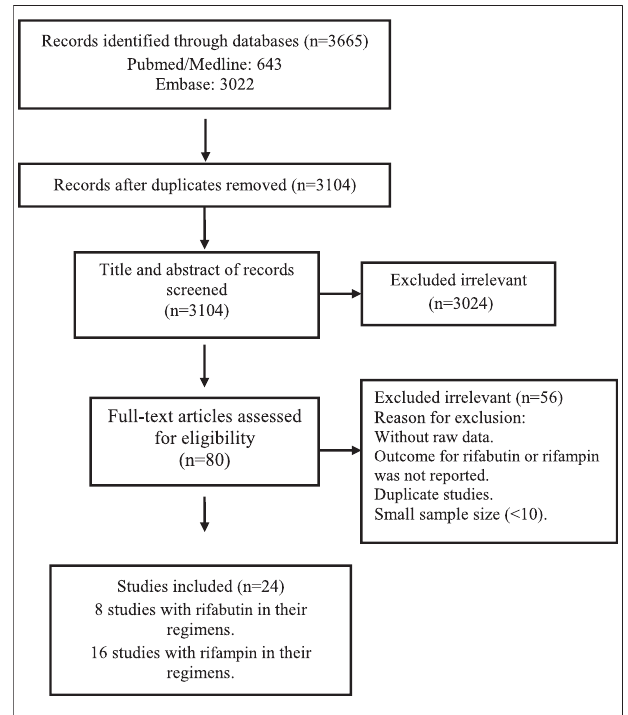
FIGURE 1 | Flow chart of study selection for inclusion in the systematic review and